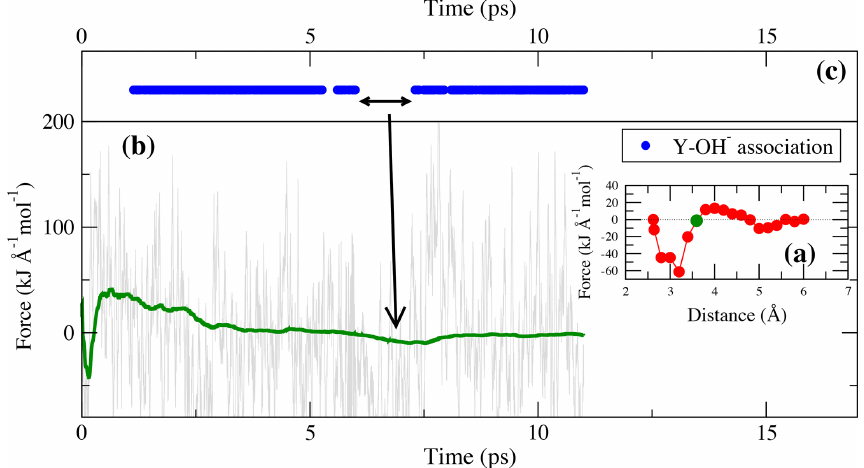
Figure 7. (a) Potential of mean force of TI-4. The green circle indicates the constraint distance of 3.6Å for which the force and cumulative mean force is shown in panel (b) . Dots in panel (c) indicate the presence of Y − OH − bonds during the simulation